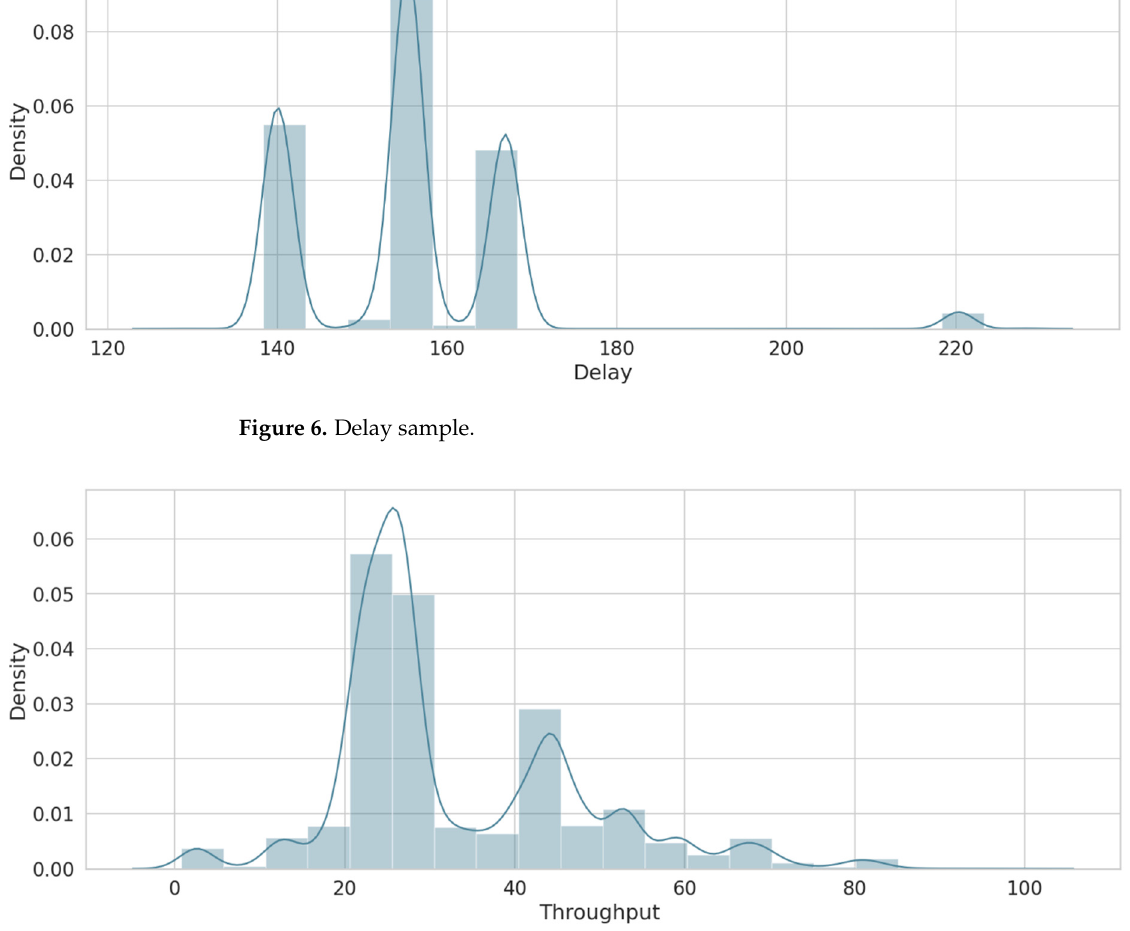
Figure 7. Throughput sample.